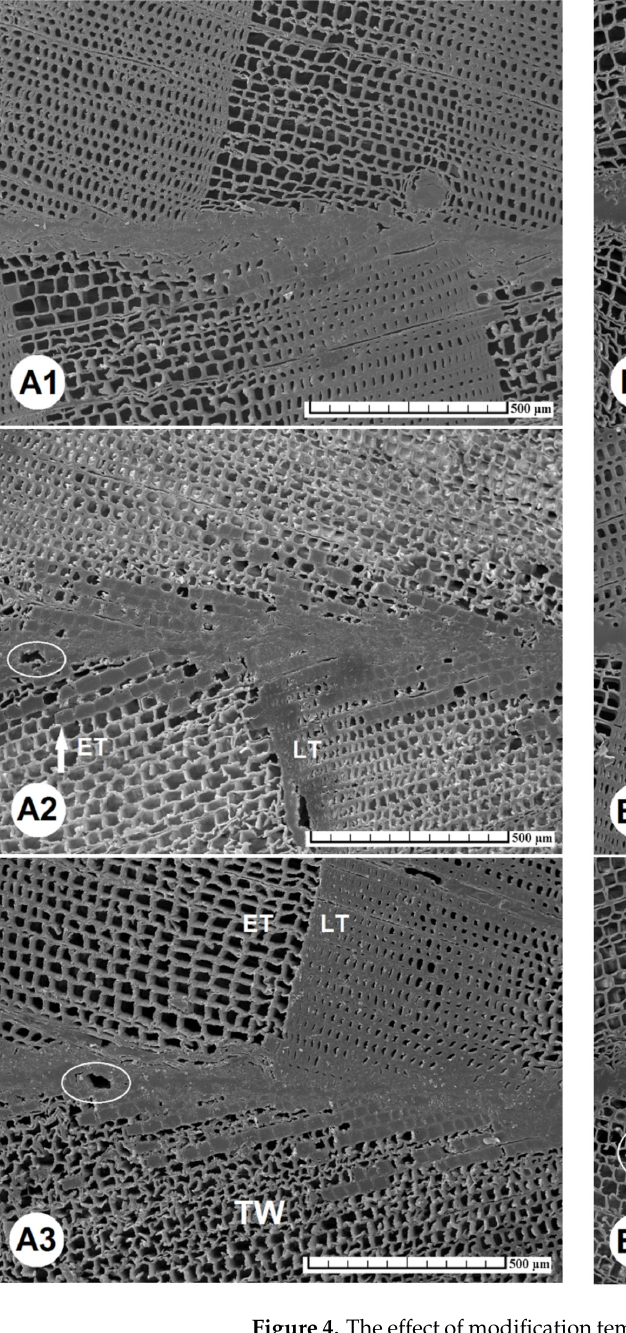
Figure 4. The effect of modification temperature on the quality of glued joints using PUR ( A1 – A3 ) and PVAc ( B1 – B3 ) glues was analyzed on the cross-section cuts. ( A1 , B1 ) show the thermally unmodified specimens—the reference testing set; ( A2 , B2 ) the thermally modified testing set (V) 220 ◦ C/220 ◦ C; and ( A3 , B3 ) the combined testing set (VI) 100 ◦ C/220 ◦ C from the reference specimen in the upper part of the image and the ThermoWood specimen in the lower part of the image. Scale bar = 500 µ